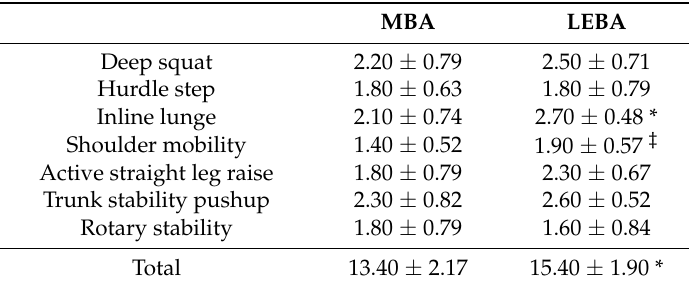
Table 6. Functional movement screen (FMS) results (mean ± SD) by body armour type and FMS movement element, and